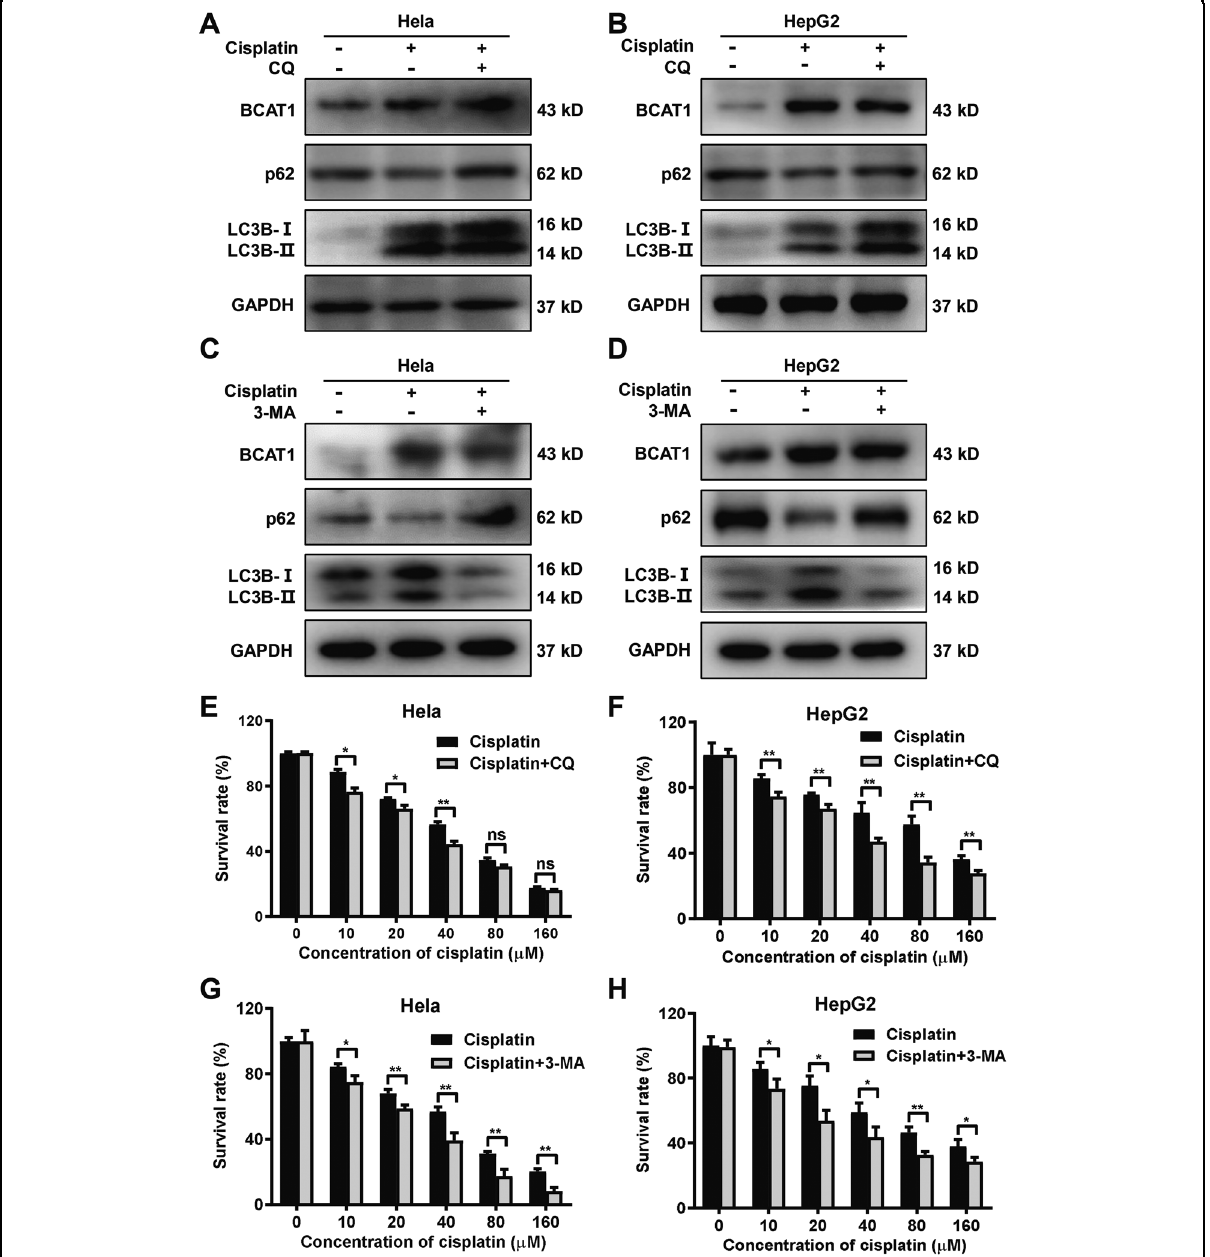
Fig. 2 Cisplatin-induced autophagy confers decreased cisplatin cytotoxicity. A , B Western blot analysis of BCAT1, p62, and LC3-I/II protein levels in the Hela ( A ) and HepG2 ( B ) cells treated with cisplatin (20 μ M and 10 μ M, respectively) alone or in combination with 20 μ M chloroquine (CQ) for 24 h. C , D Western blot analysis of BCAT1, p62, and LC3-I/II protein levels in the Hela ( C ) and HepG2 ( D ) cells treated with cisplatin (20 μ M and 10 μ M, respectively) alone or in combination with 2 mM 3-methyladenine (3-MA) for 24 h. E , F Cell viability was assessed by CCK-8 assays. Hela ( E ) and HepG2 ( F ) cells were incubated with increasing concentrations of cisplatin alone or in combination with CQ (20 μ M) for 24 h. G , H Cell viability was assessed by CCK-8 assays. Hela ( G ) and HepG2 ( H ) cells were incubated with increasing concentrations of cisplatin alone or in combination with 3-MA (2 mM) for 24 h. Three independent experiments were performed. ns, not signi fi cant. * P < 0.05, ** P <